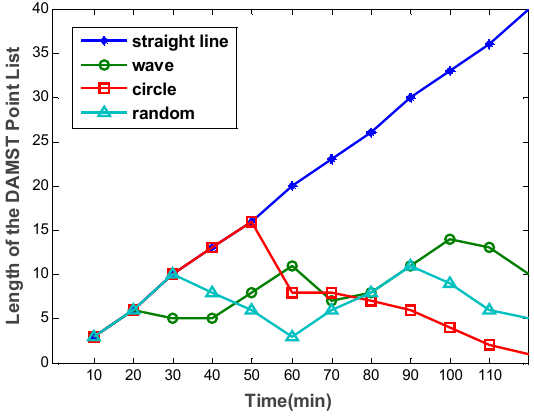
Figure 10. Length of the DAMST point list in the four trajectory patterns.